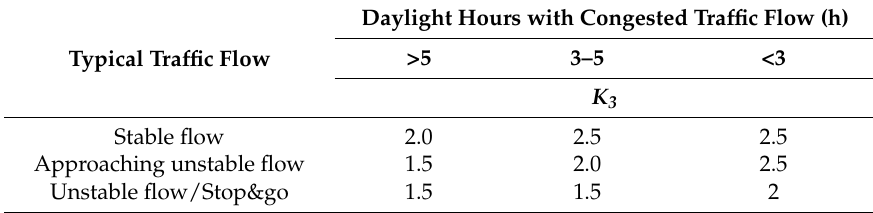
Table 4. Values of the motorized traffic factor K 3